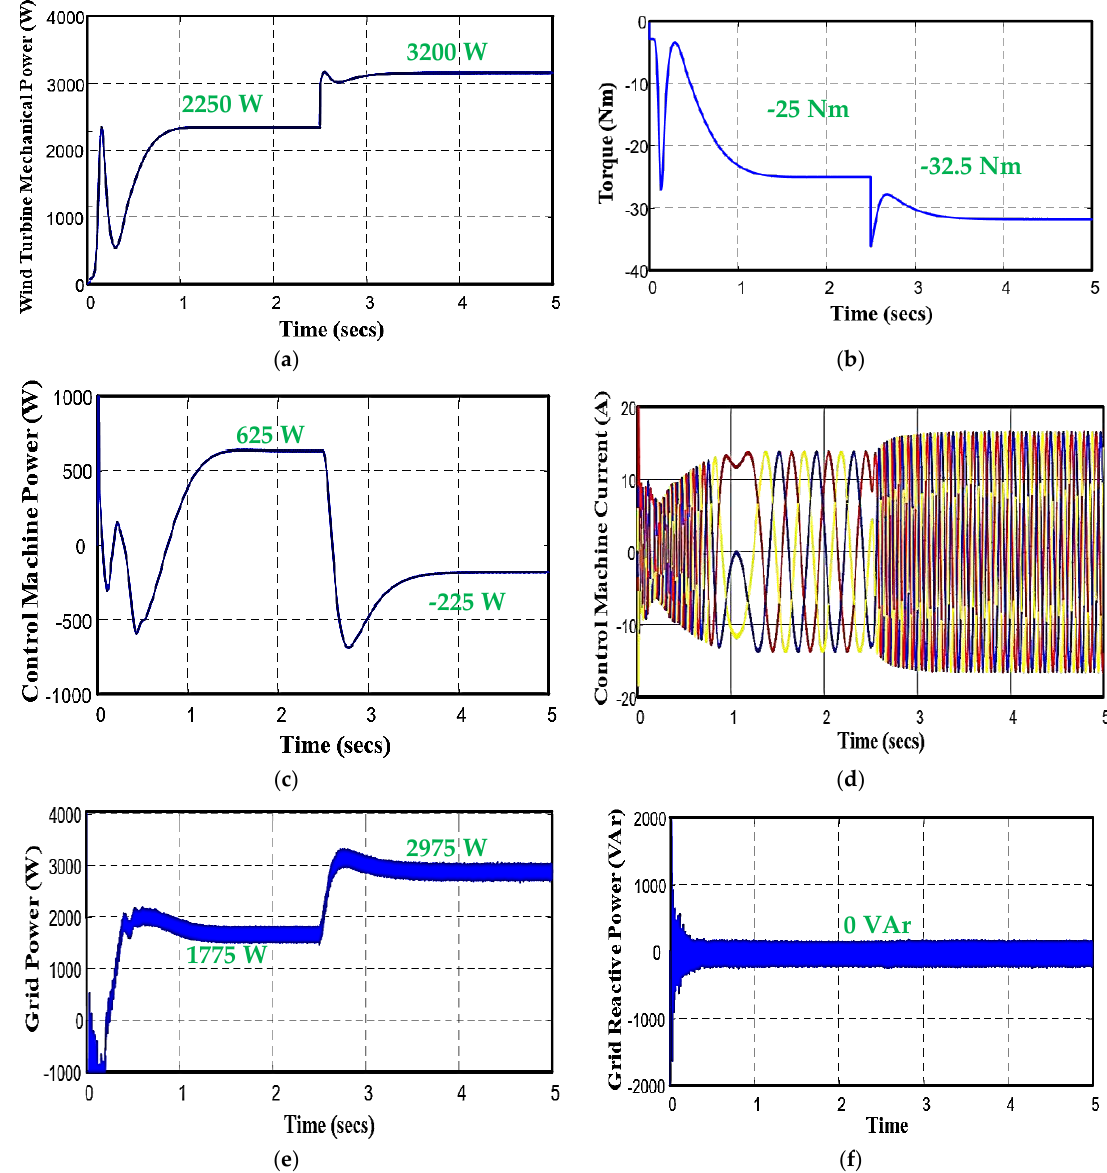
Figure 10. System performance under variable speed command and constant reactive power reference: ( a ) input mechanical power, Pm , V , ( b ) input torque, Tm ( c ) control machine power, Pc , ( d ) control machine current, I abcc , ( e ) grid power, P g ( f ) grid reactive power, Q g.